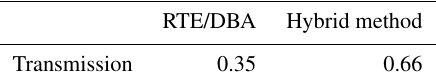
Figure 8. Tree trunks (left) are modeled as dielectric cylinders (right). The figure is adapted from Huang et al. (2019). Table 1. Transmission coefficient from RTE based on distorted Born approximation (RTE/DBA) and the hybrid method from Fig. 8. The table is adapted from Huang et al.